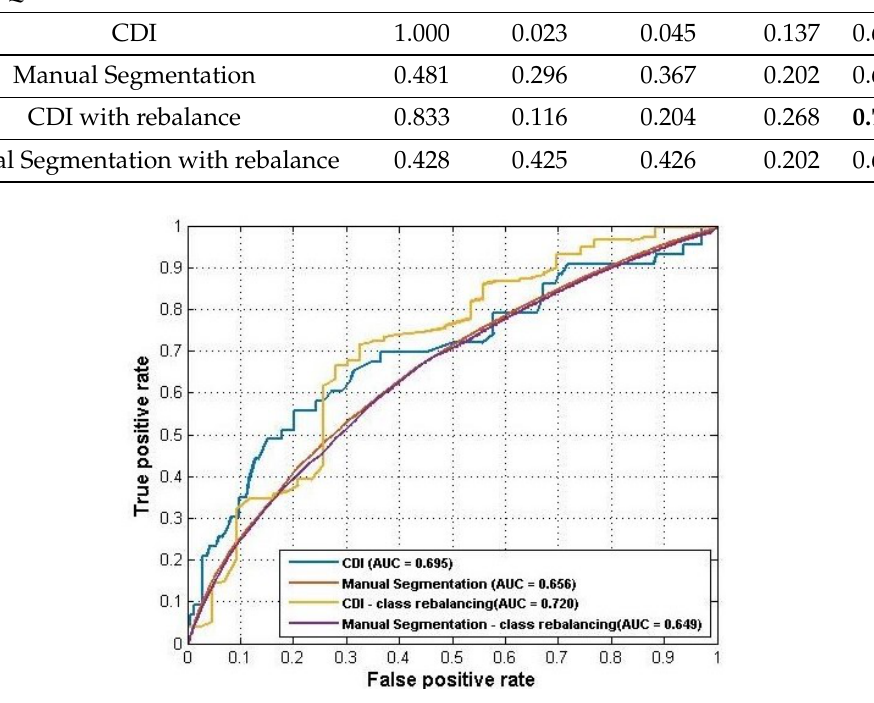
Figure 6. ROC plot of bottom CDI (#1–9) and manual segmentation at whole media